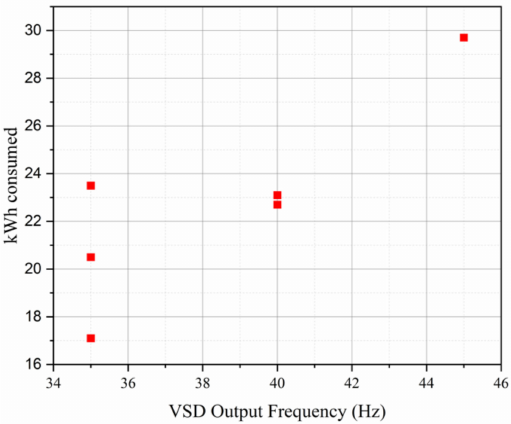
Figure 5. Electrical energy consumption variation with hydraulic pump motor speed in VSD control.